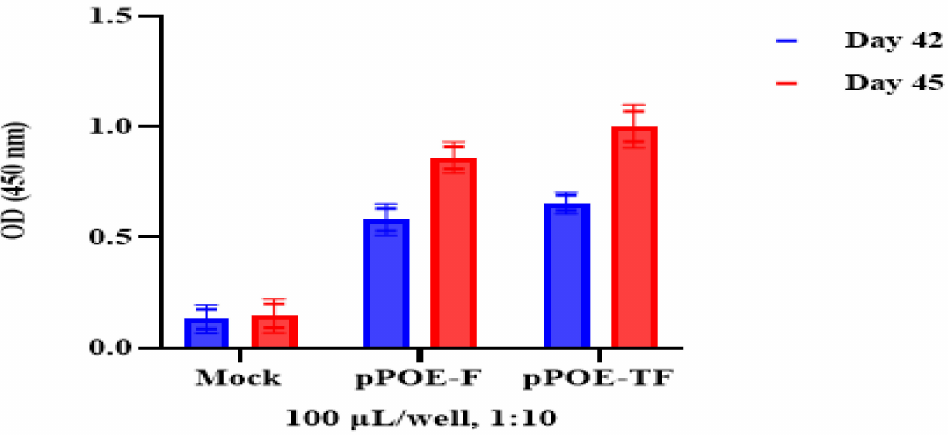
Figure 1. The evaluation of human orthopneumovirus F MPA levels in serum at day 42 and day 45. OD values are the mean of two independent experiments and bars represent means ± SD measured in each group. Differences between rats immunized with pPOE-F and pPOE-TF were statistically